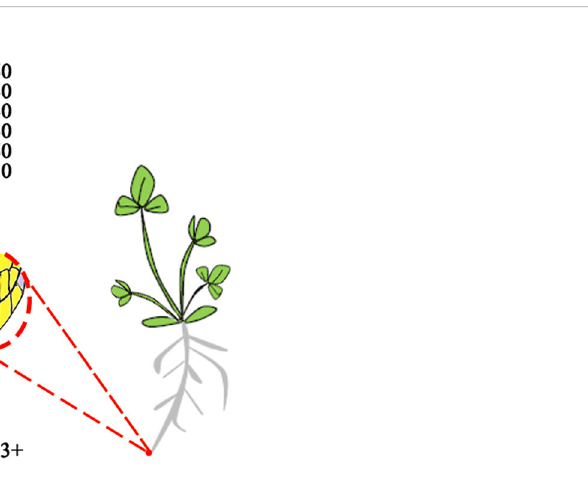
FIGURE 5 Analysis of expression patterns of miRNA and target genes affecting the root system of M. truncatula under aluminum